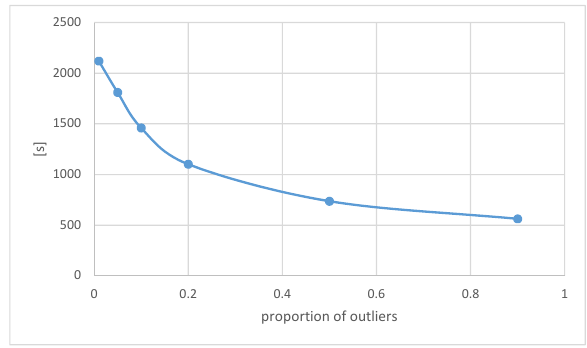
Figure 9. Runtime for different proportions of outliers